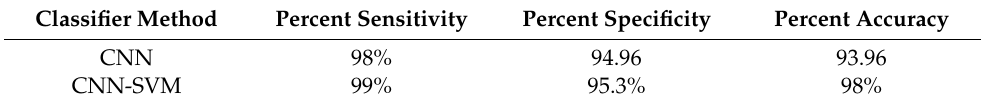
Table 3. Validation results of the training set based on sensitivity, specificity, and accuracy.